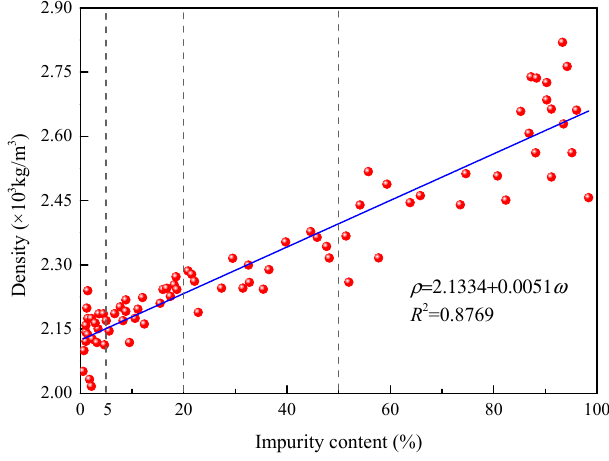
Figure 3. Density of the salt rock specimens versus impurity content.